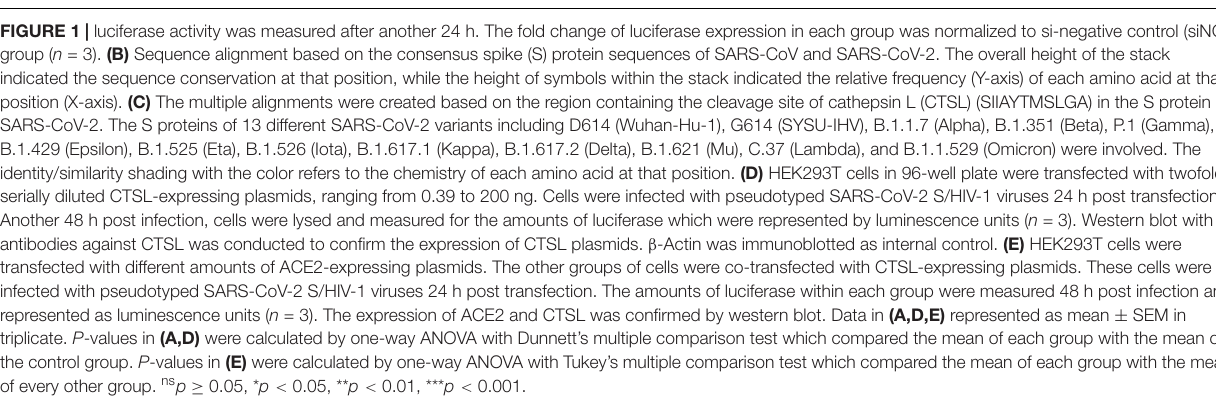
FIGURE 1 | luciferase activity was measured after another 24 h. The fold change of luciferase expression in each group was normalized to si-negative control (siNC) group ( n = 3). (B) Sequence alignment based on the consensus spike (S) protein sequences of SARS-CoV and SARS-CoV-2. The overall height of the stack indicated the sequence conservation at that position, while the height of symbols within the stack indicated the relative frequency (Y-axis) of each amino acid at that position (X-axis). (C) The multiple alignments were created based on the region containing the cleavage site of cathepsin L (CTSL) (SIIAYTMSLGA) in the S protein of SARS-CoV-2. The S proteins of 13 different SARS-CoV-2 variants including D614 (Wuhan-Hu-1), G614 (SYSU-IHV), B.1.1.7 (Alpha), B.1.351 (Beta), P.1 (Gamma), B.1.429 (Epsilon), B.1.525 (Eta), B.1.526 (Iota), B.1.617.1 (Kappa), B.1.617.2 (Delta), B.1.621 (Mu), C.37 (Lambda), and B.1.1.529 (Omicron) were involved. The identity/similarity shading with the color refers to the chemistry of each amino acid at that position. (D) HEK293T cells in 96-well plate were transfected with twofold serially diluted CTSL-expressing plasmids, ranging from 0.39 to 200 ng. Cells were infected with pseudotyped SARS-CoV-2 S/HIV-1 viruses 24 h post transfection. Another 48 h post infection, cells were lysed and measured for the amounts of luciferase which were represented by luminescence units ( n = 3). Western blot with antibodies against CTSL was conducted to confirm the expression of CTSL plasmids. β -Actin was immunoblotted as internal control. (E) HEK293T cells were transfected with different amounts of ACE2-expressing plasmids. The other groups of cells were co-transfected with CTSL-expressing plasmids. These cells were infected with pseudotyped SARS-CoV-2 S/HIV-1 viruses 24 h post transfection. The amounts of luciferase within each group were measured 48 h post infection and represented as luminescence units ( n = 3). The expression of ACE2 and CTSL was confirmed by western blot. Data in (A,D,E) represented as mean ± SEM in triplicate. P -values in (A,D) were calculated by one-way ANOVA with Dunnett’s multiple comparison test which compared the mean of each group with the mean of the control group. P -values in (E) were calculated by one-way ANOVA with Tukey’s multiple comparison test which compared the mean of each group with the mean of every other group. ns p ≥ 0.05, * p < 0.05, ** p < 0.01, *** p <